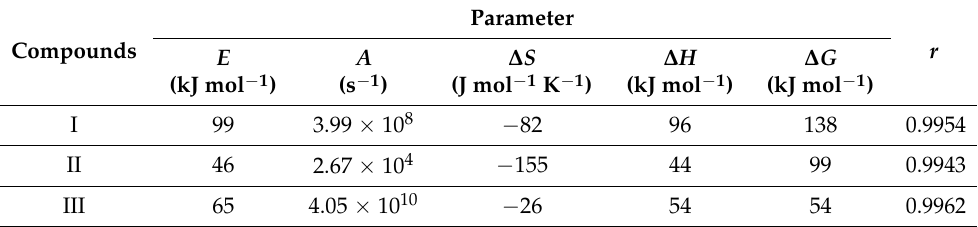
(cid:16) − (cid:17) ln ( 1 − α ) against 1 was found to be linear, from the slope of which T T 2